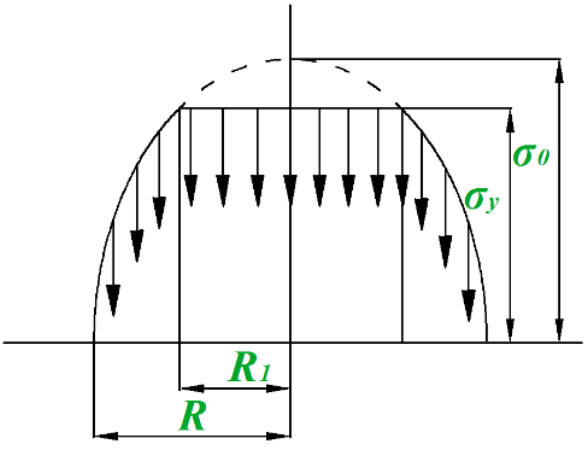
Figure A1. Schematic diagram of stress distribution in elastic-plastic indentation of the wall.